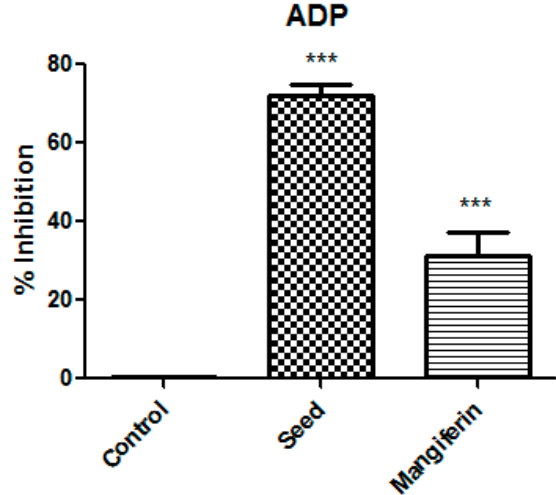
Figure 3. Antiplatelet aggregation activity results of mango seed extract and mangiferin at 1.0 mg/mL against ADP agonist (4 µM) expressed as mean value of inhibition percentages ( n = 6). Data was analyzed using ANOVA of one factor. Post hoc analyses were conducted by Tukey’s test. *** denotes significant differences compared to the negative control (absence of extract) at p = 0.001; ns denotes no statistical differences.